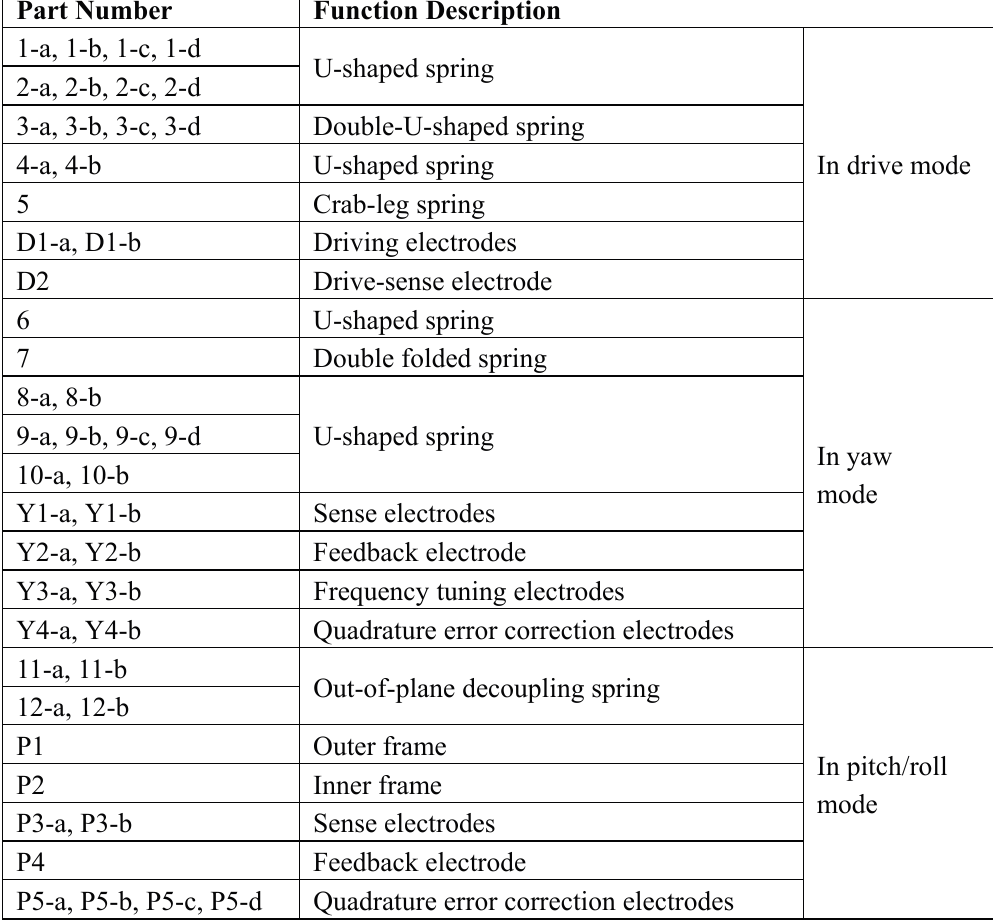
Table 1. Summary of part numbers and function description in three